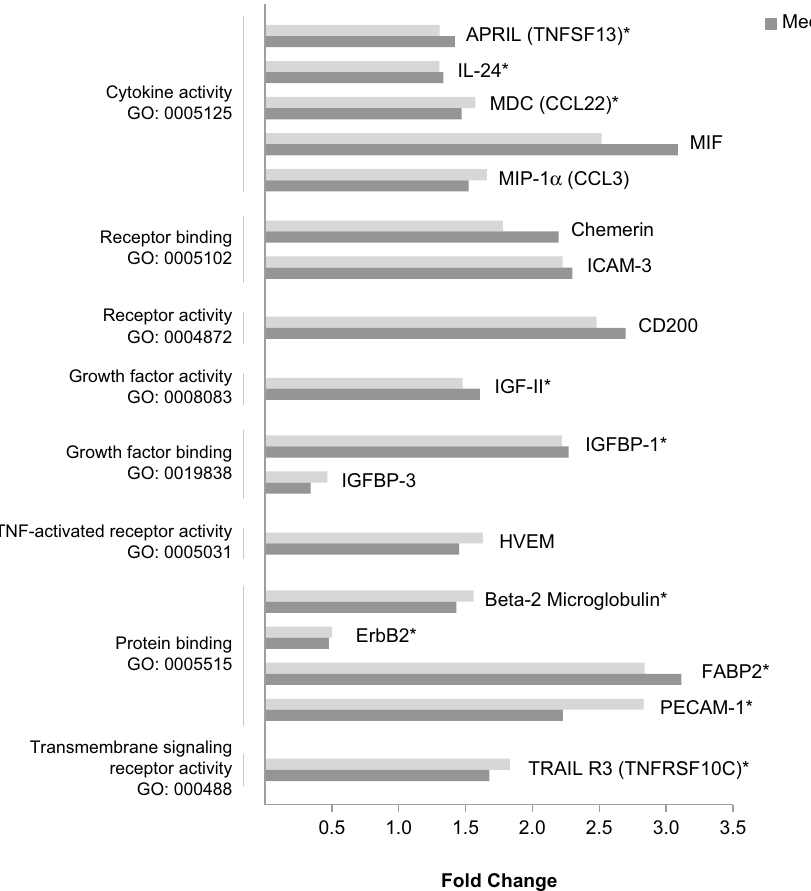
Figure 2. Proteins with altered serum levels in patients undergoing aseptic loosening, as quantified using antibody arrays. Bar graphs showing fold changes of mean ( ) or median ( ) values of the protein levels in the aseptic hip revision (AL) group relative to the primary THA (PR) group. Proteins were clustered according to their molecular function and gene ontology (GO) term. * p < 0.05.